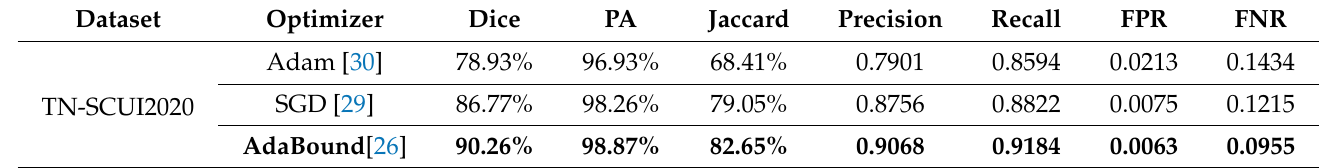
Table 5. Comparison of thyroid nodule segmentation performance using various optimizers.